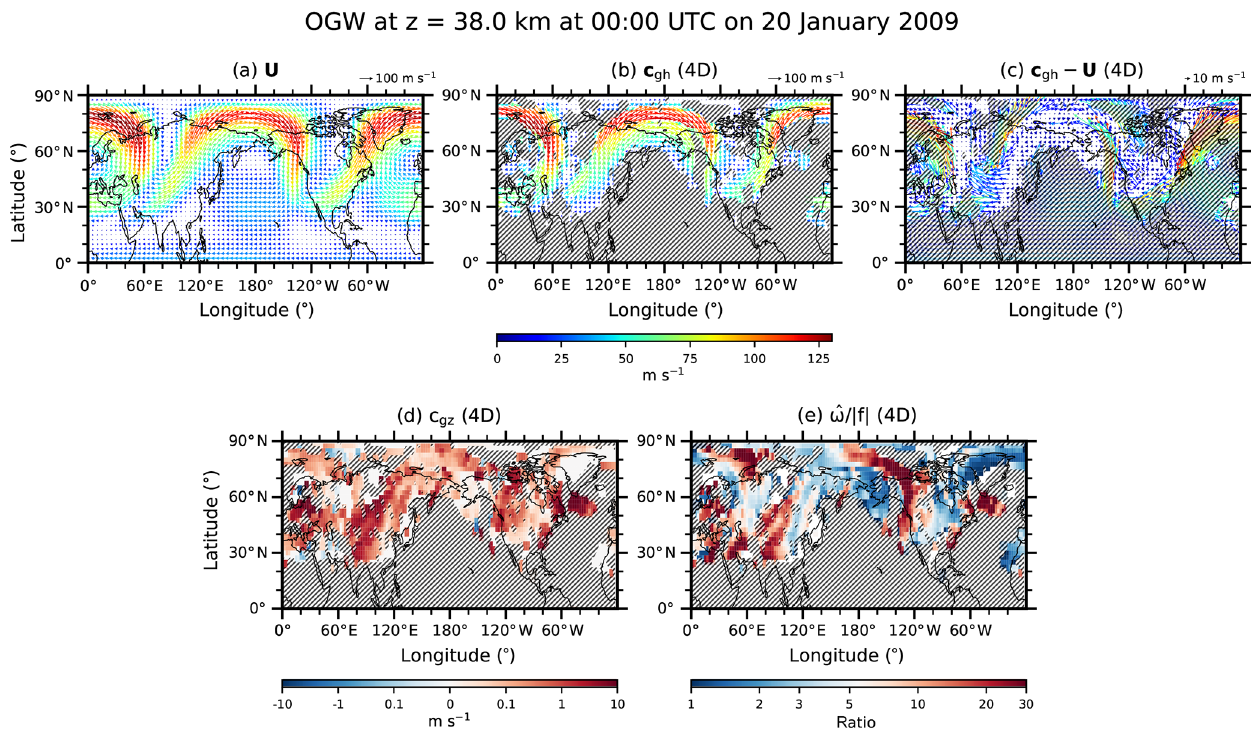
Figure 11. Longitude–latitude cross sections of (a) horizontal wind ( U ), ensemble means of (b) the horizontal group velocity ( c gh ), (c) the horizontal intrinsic group velocity ( c gh − U ), (d) the vertical component of the group velocity ( c gz ), and (e) ratio of intrinsic frequency ( (cid:98) ω ) to Coriolis parameter ( | f | ) for OGW at z = 38km in the 4D experiment at 00:00UTC on 20 January 2009. Hatched areas indicate regions where the paired and two-tailed t test for the 4D and 2D experiments gives p values larger than 0.05 (i.e., no statistical significance at the level of 0.05). For hatching over horizontal vector fields (b–c) , the mean value of p values for the zonal and meridional components is